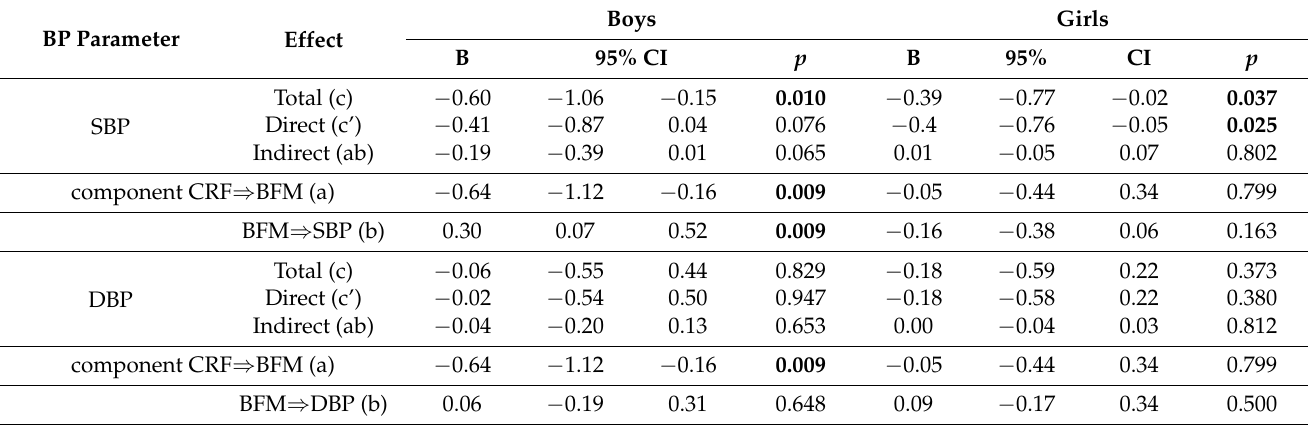
Table 3. The mediation effects of the baseline BFM: total (path c), direct (path c’), and indirect (ab) with its components (paths a and